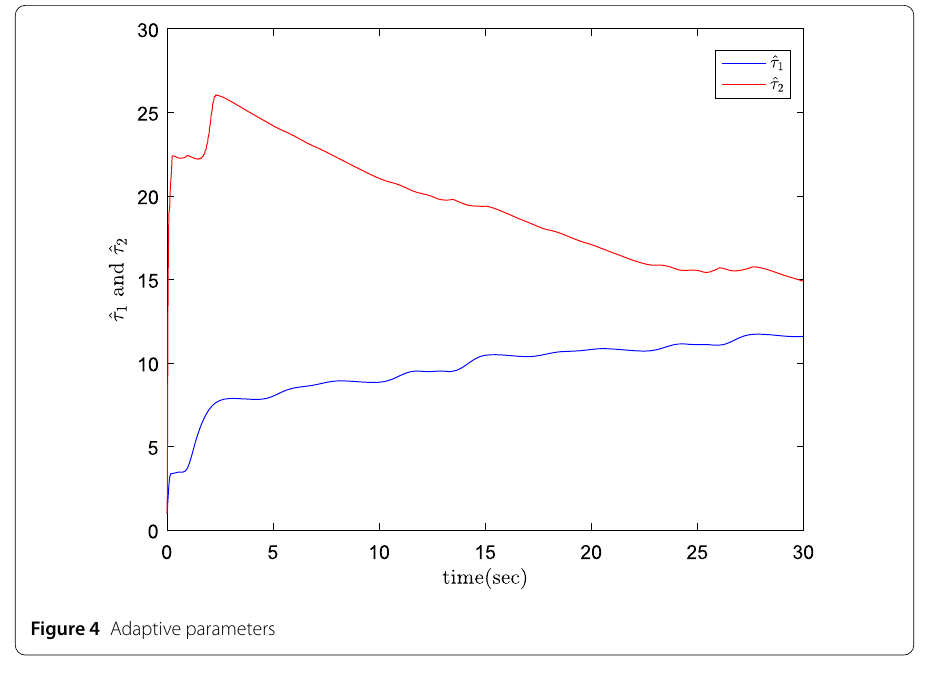
Figure 4 Adaptive parameters